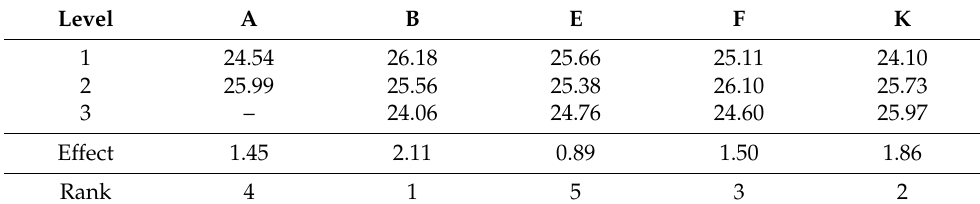
Table 10. Factor response table for the S/N ratios of the L 18 (2 1 × 3 7 ) experiment.